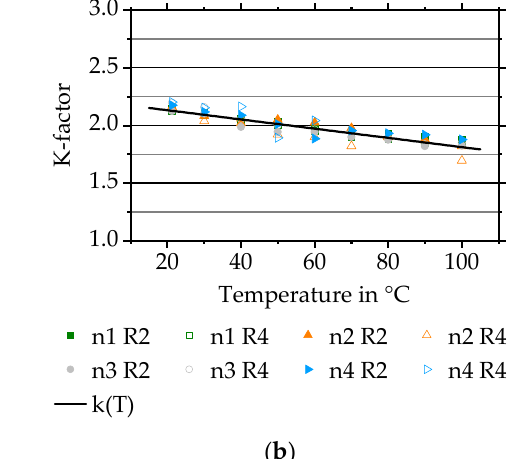
Figure 6. ( a ) The resistance change of Constantan and NiCr 80/20 quarter-bridges R1-R4 with protective layer (PL) compared to Constantan and NiCr 80/20 quarter-bridges without protective layer at 150 °C. ( b ) Ten hours long-time behaviour of Constantan and NiCr 80/20 quarter-bridges, R1 and R2, with and without protective layer at 150 °C.